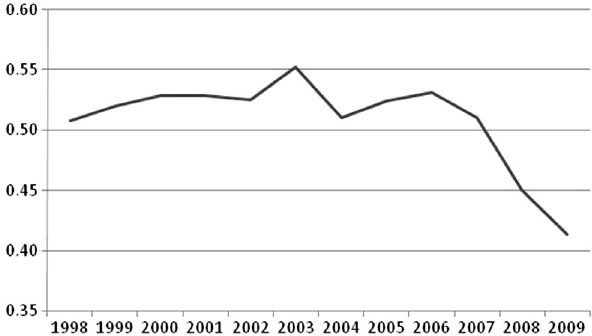
Fig. 5. Sigma convergence of non-contributory social spending expressed in purchasing power parity, in the EU-8+2 according to the average net earnings in the EU-15, 1998–2009 Source: Authors’ calculation based on Eurostat database